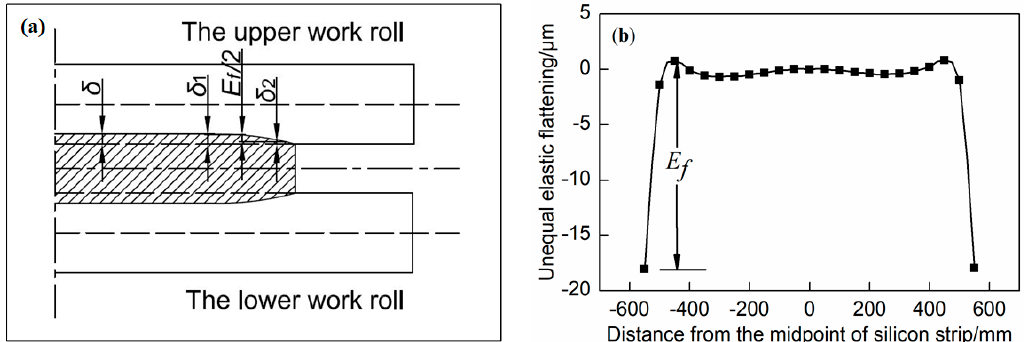
Figure 7. The edge drop for the unequal flattening of the work roll: ( a ) Value of flattening at any point of the work roll; and ( b ) finite element calculation results.